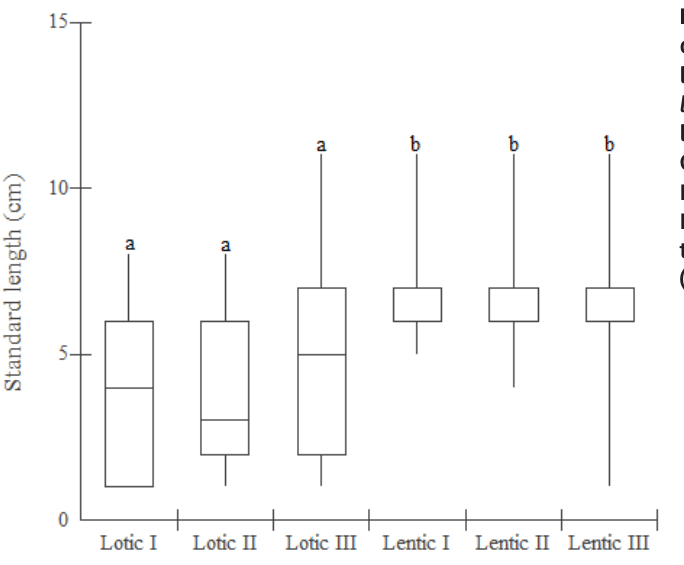
Figure 2. Median and quartiles of standard length (cm) of Astyanax lacustris from the lentic and lotic sites of Chavantes Reservoir, Paranapanema